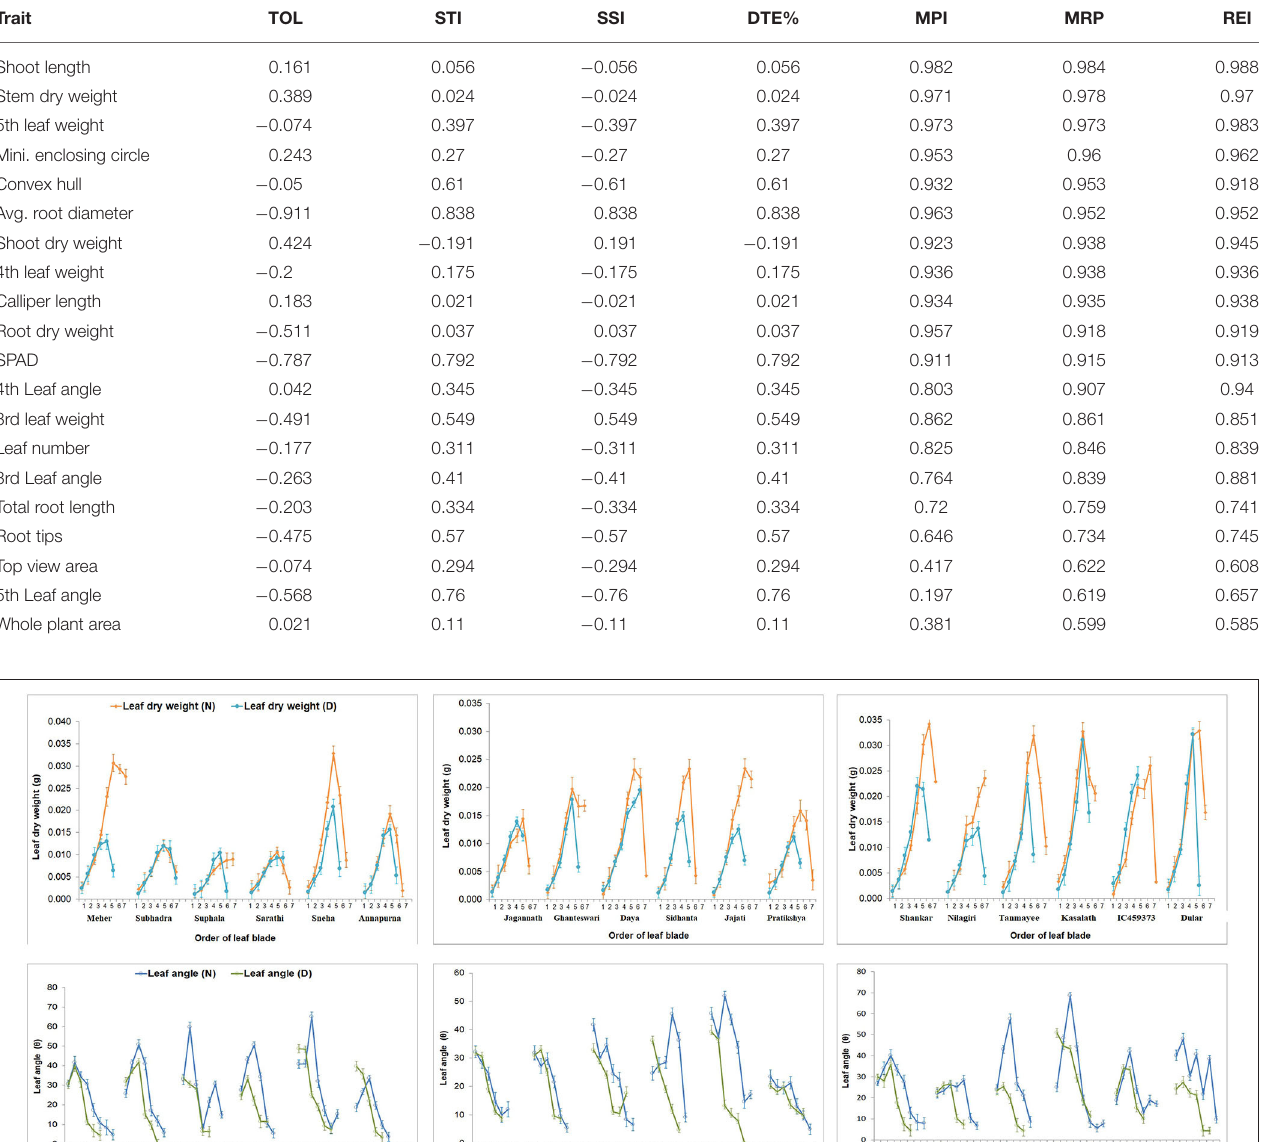
TABLE 3 | Relationship ( r ) between tolerance indices and some selected traits measured under P deficient conditions. Trait